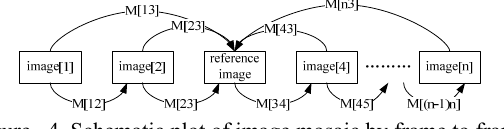
Figure 4. Schematic plot of image mosaic by frame to frame